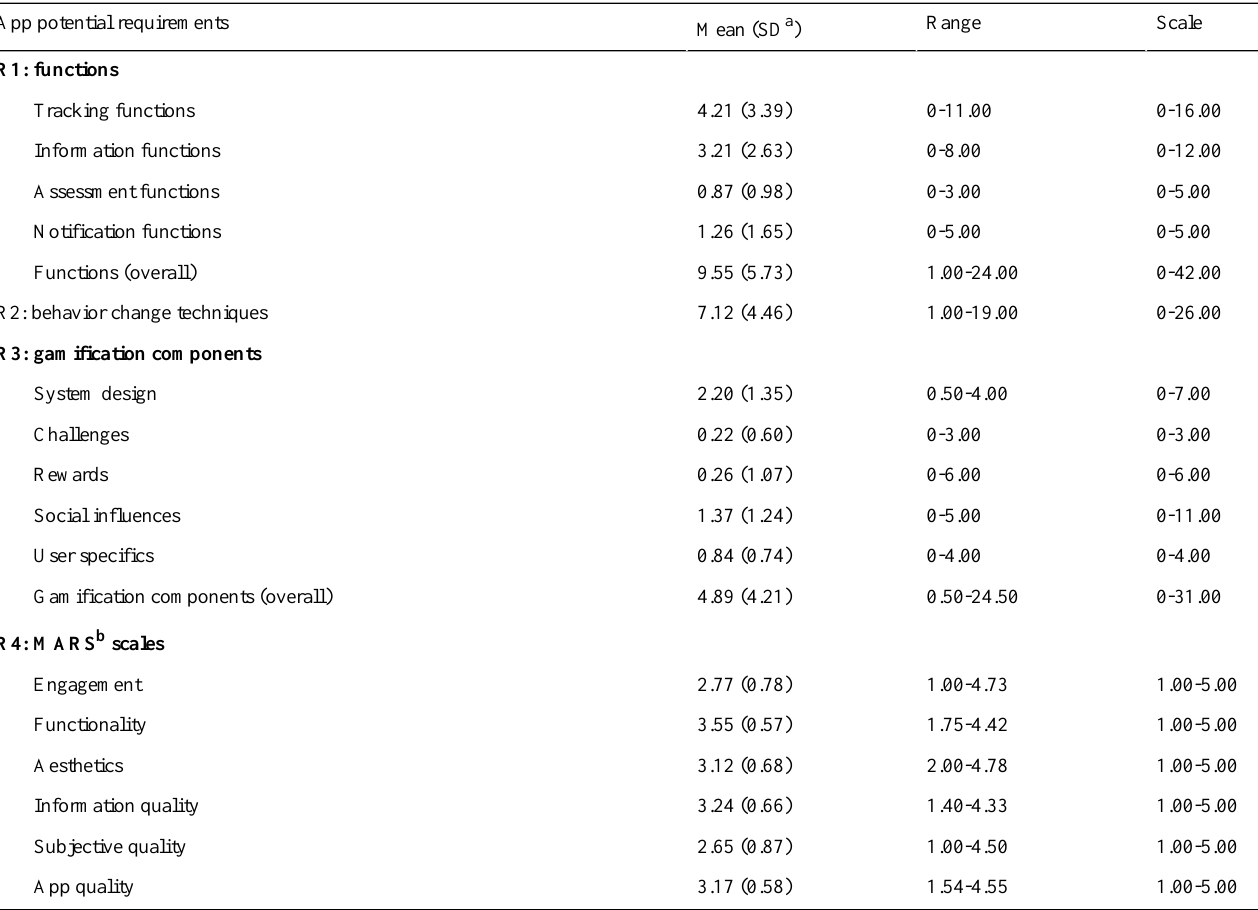
Table 3. Summary of all rated app potential requirements. Behavior change techniques or gamification components rated as “fully applied” and “partially applied” were included in the analysis.